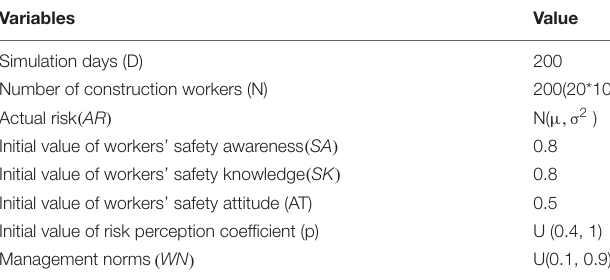
TABLE 1 | Initial value setting of relevant